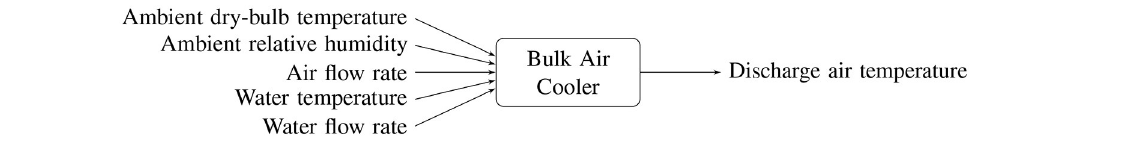
FIGURE2 Application layout depicting parameters affecting the discharge air